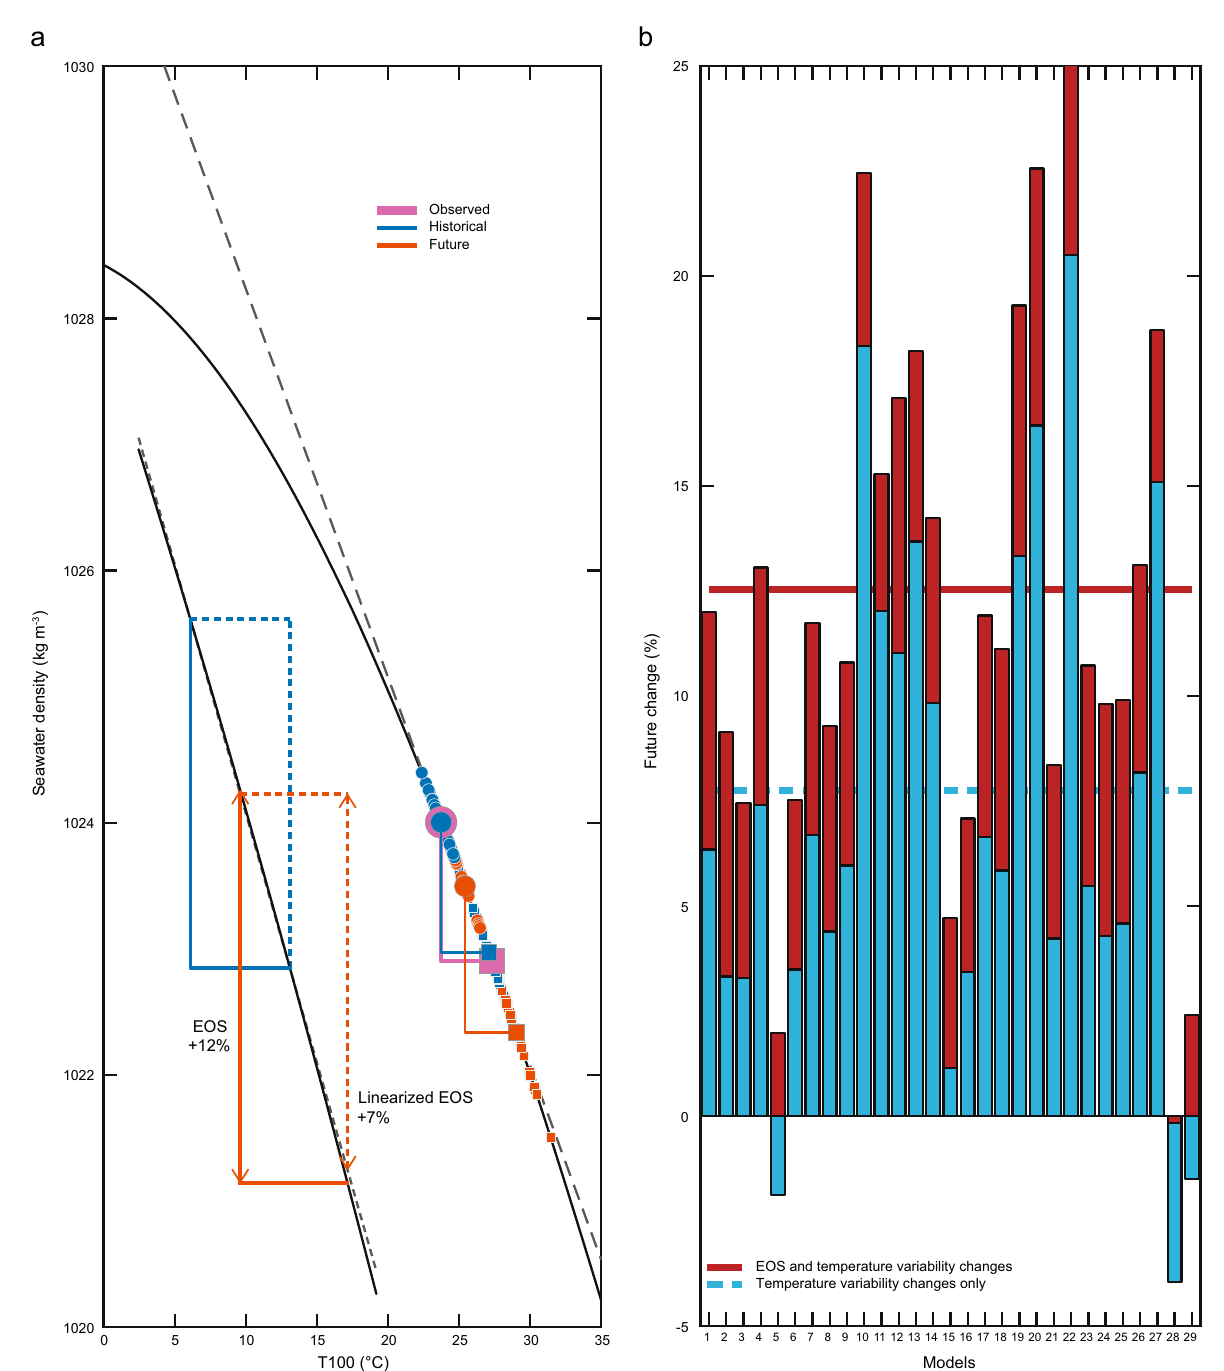
Fig. 3 Seawater density (kg m − 3 ) variability associated with the annual cycle of T100 (°C) around the City of Miami, Florida from observations and CMIP5 models. a The seawater density-temperature relationship (black lines) is shown with ORA-S5 (magenta), historical (blue), and future (orange) projections overlaid. Circles and squares indicate respectively the T100 annual cycle minimum and maximum for each model (smaller shapes) and the multi-model average as well as ORA-S5 (larger shapes). Horizontal and vertical lines indicated the T100 and density ranges, respectively, for ORA-S5 and the multi-model average for the historical and future projections. The insert illustrates the different future increases in density variability expected according to the EOS (solid) and a version of the EOS linearized around the historical T100 range (dashed; i.e., using a constant thermal expansion coef fi cient). b Future change (RCP8.5 with respect to the historical experiment; %) of the density annual cycle for each model (bars) and the multi-model average (horizontal lines). Red indicates the total change and blue indicates the component of change associated with temperature variability